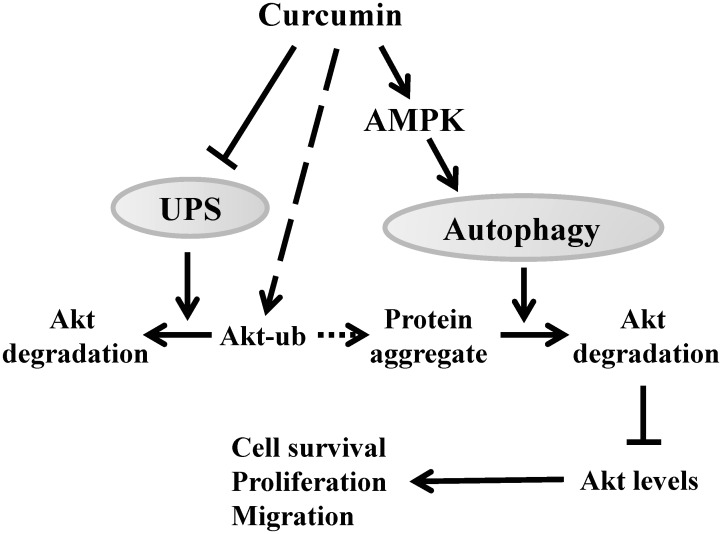
A schematic diagram of curcumin-induced Akt degradation.Autophagy is upregulated in curcumin-treated MDA-MB-231 breast cancer cells via an AMPK-mediated mechanism. The precise mechanism that regulates Akt ubiquitination and aggregation remains unclear; however, the presence of activated autophagy will result in degradation of the aggregated Akt leading to a reduction in Akt levels.